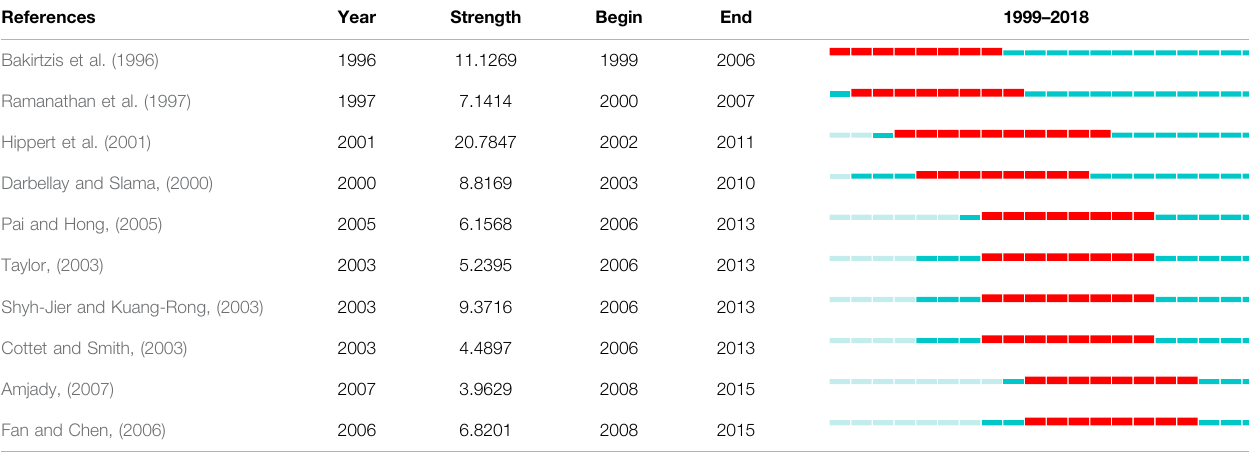
TABLE 7 | Top 10 references with the strongest citation bursts during 1999 –